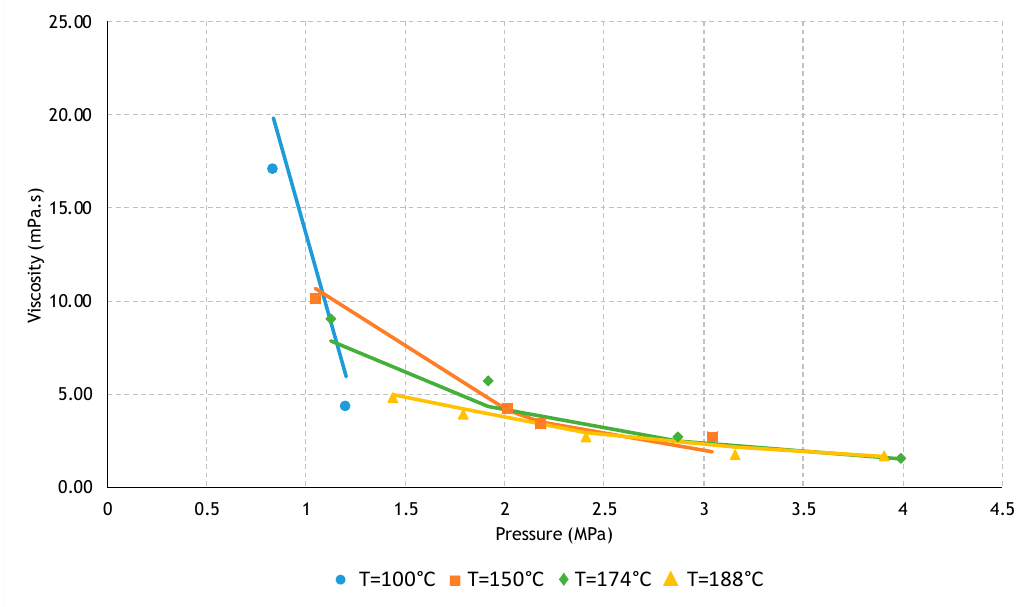
Figure 7. Comparison between experimental and simulated viscosity values for mixtures of butane-bitumen at different equilibrium pressures and temperatures. The experimental values are represented by different symbols and were taken by Nourozieh et al. [28].